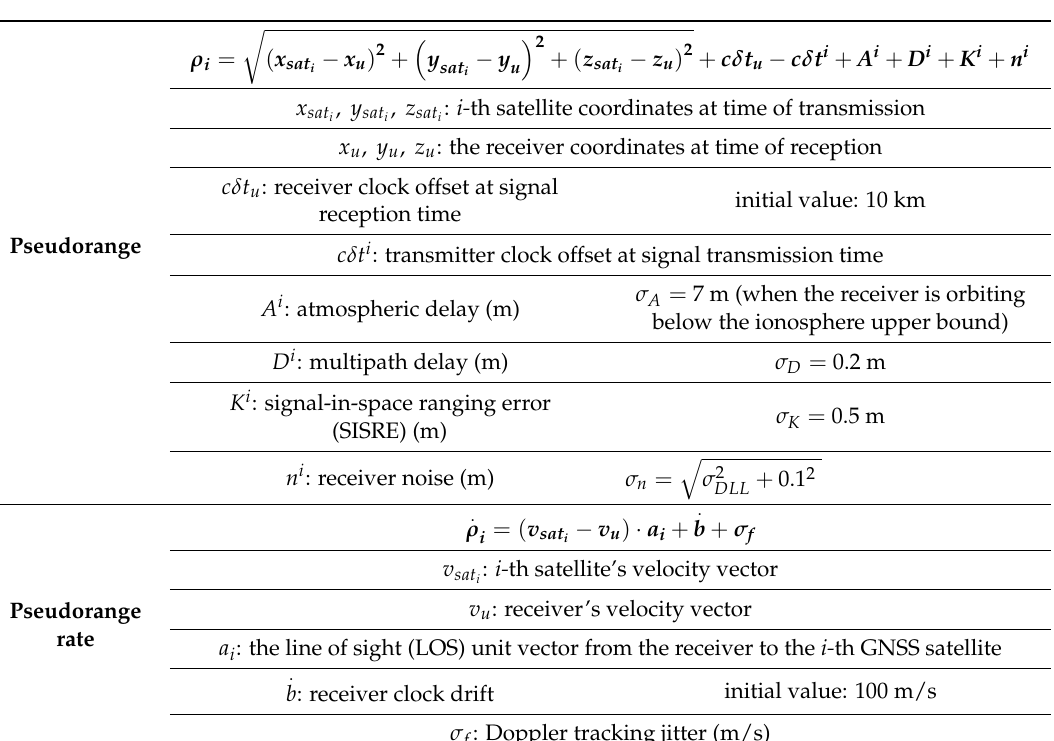
Table 1. Observations and